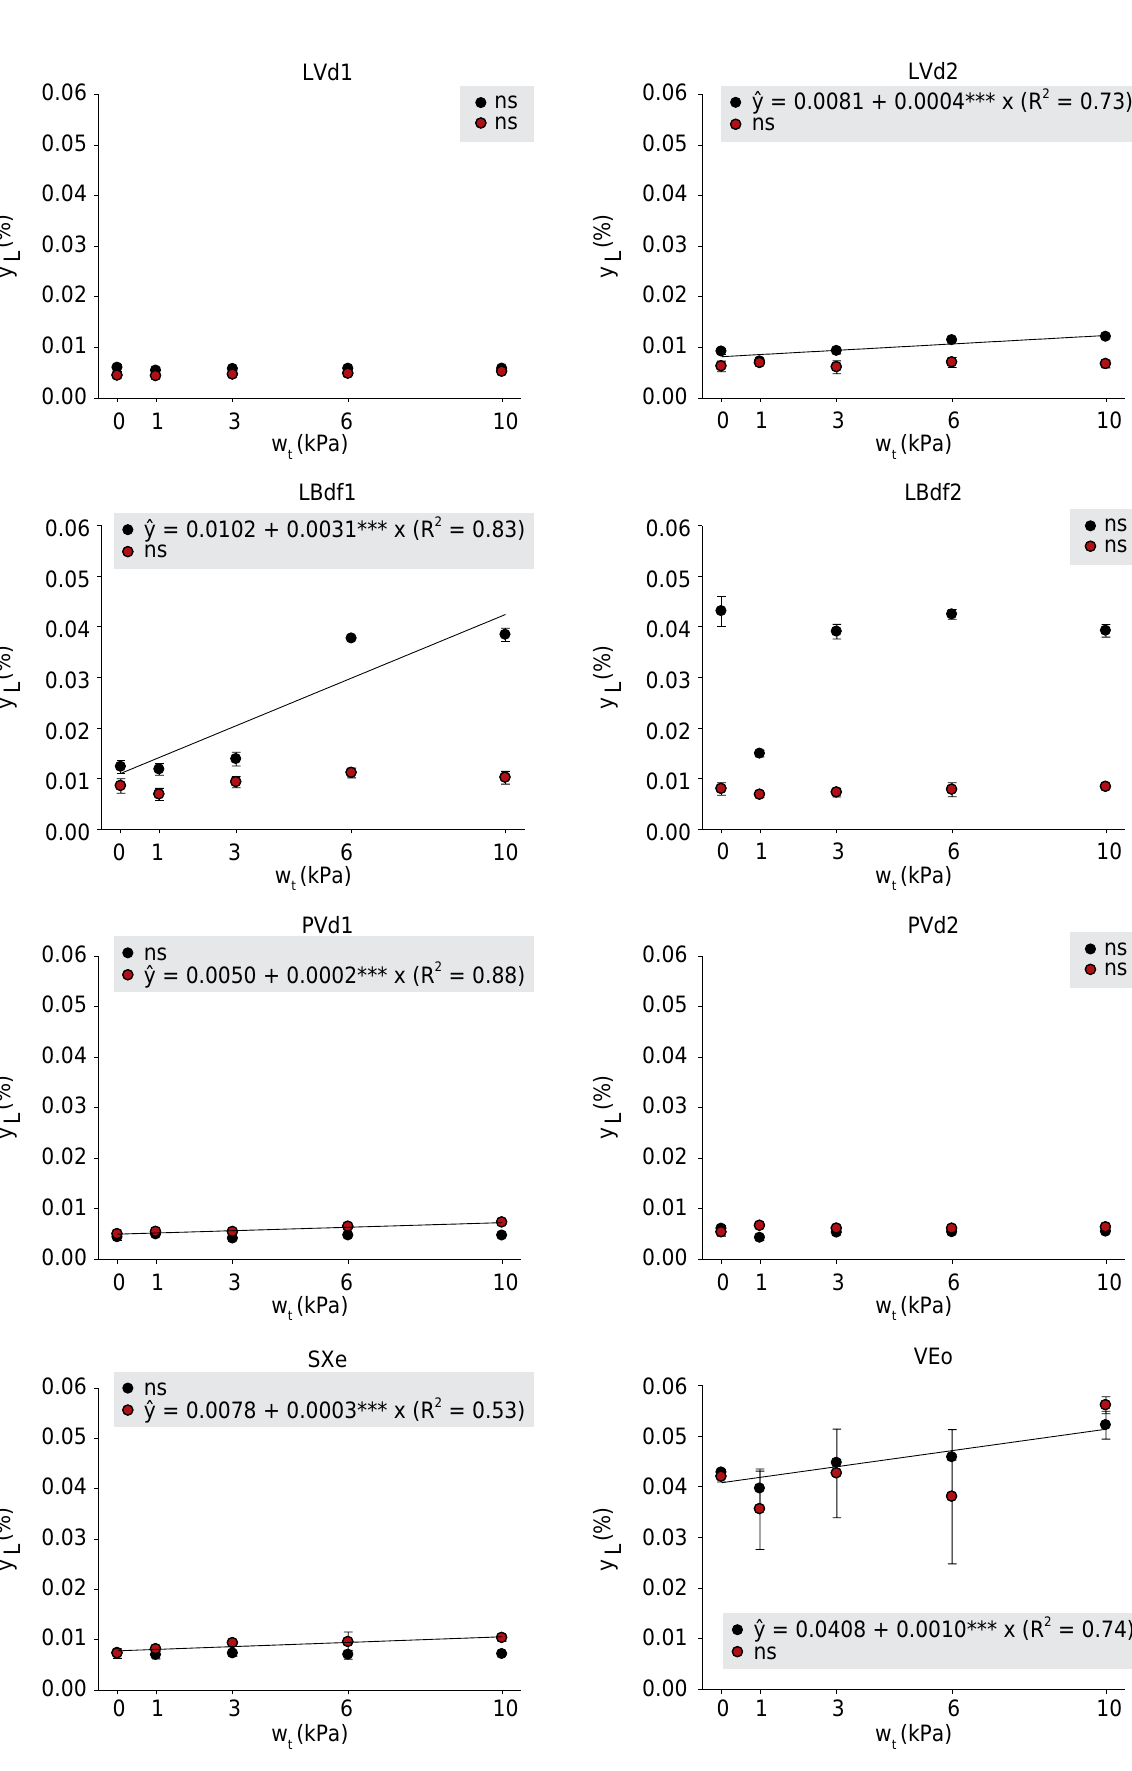
Figure 2. Deformation limit (γ L ) as a function of soil water tension (w t ) for A horizons (black symbols) and B horizons (red symbols) of Latossolos /Oxisols (LVd1, LVd2, LBdf1, LBdf2), Argissolos /Ultisols (PVd1, PVd2), Planossolo /Alfisol (SXe), and Vertissolo /Vertisol (VEo). *, ** and ***: significant at 5, 1 and 0.1 %, respectively; ns: not